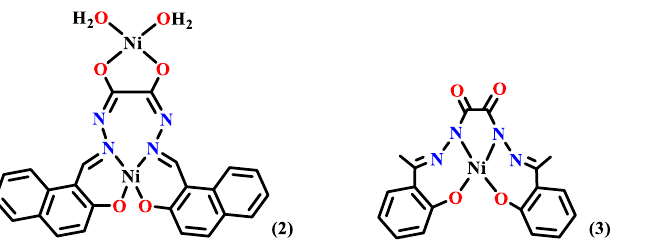
Figure 8. The new binuclear nickel(II) complex bridge coordinated by a special dihydrazone linked by oxamide.